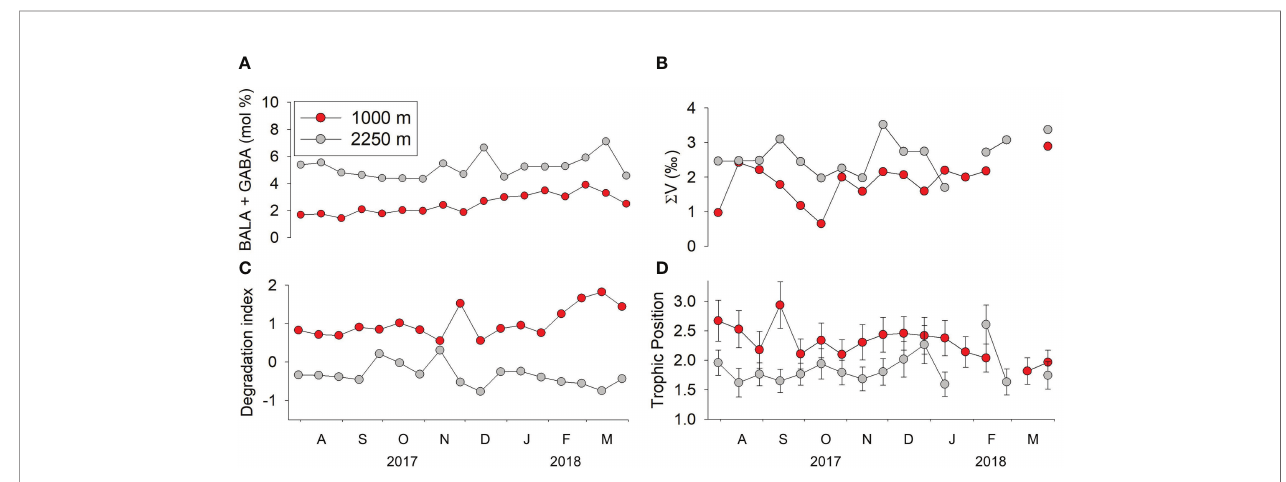
FIGURE 7 | The diagenetic parameters of sinking particles at depths of 1000 m and 2250 m. (A) molar percentage of non-proteinaceous AAs (BALA+GABA), (B) degradation index, (C) S V values estimated by trophic AAs, and (D) trophic